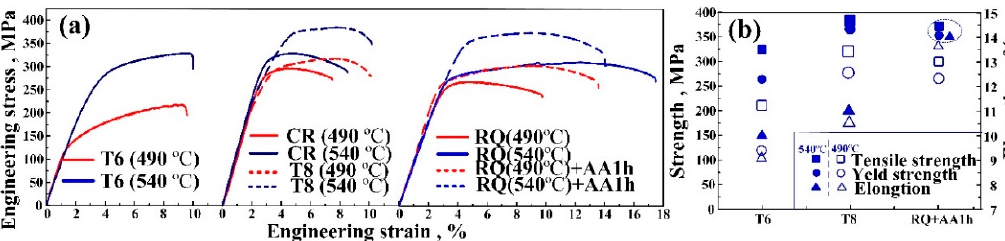
Figure 5. ( a ) The engineering stress-strain curves of samples subjected to T6, T8, RQ and ( b ) Ultimate tensile strength (UTS), yield strength and total elongation values of T6, T8 and RQ + AA 1 h samples.